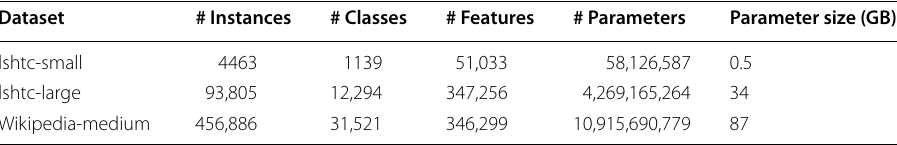
Table 1 Dataset